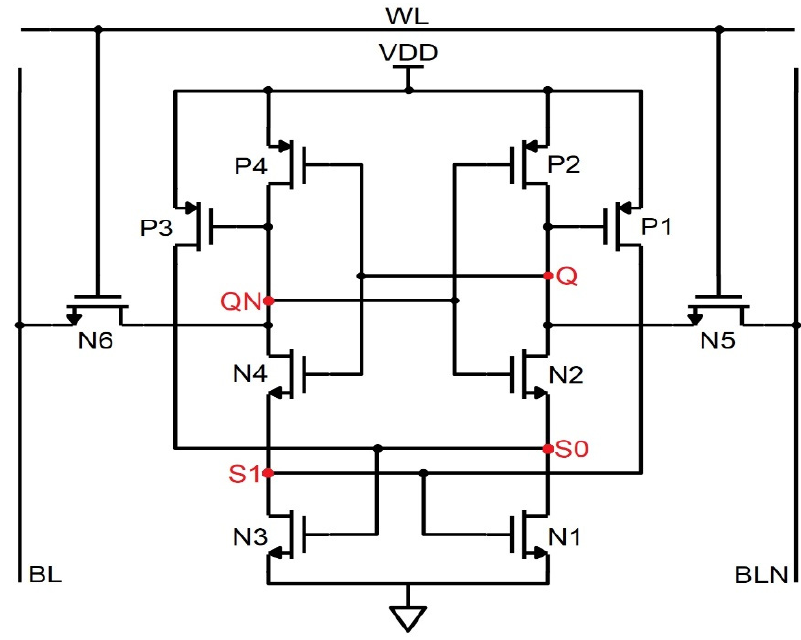
Figure 7. Schematic of the NMOS stacked 10T SRAM (NS-10T).